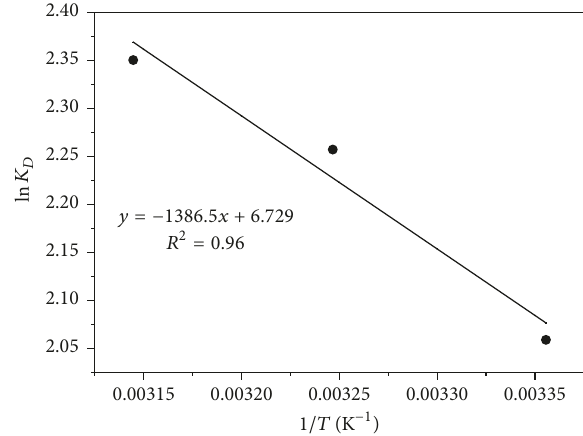
Figure 11: Thermodynamic parameters linear fit.